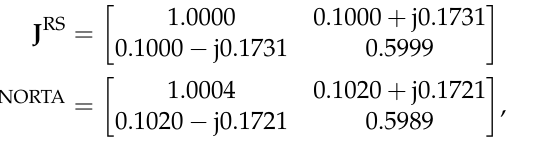
, ( d – f ) theory, RS, NORTA p E r x , E i x